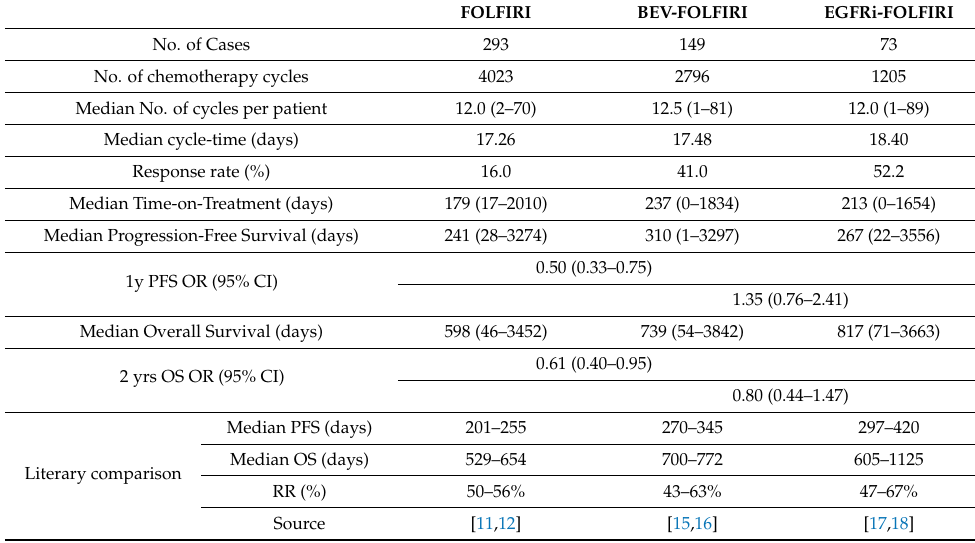
Table 1. Summary of chemotherapy-specific and survival data of the analyzed treatments, and comparison of these results with literary